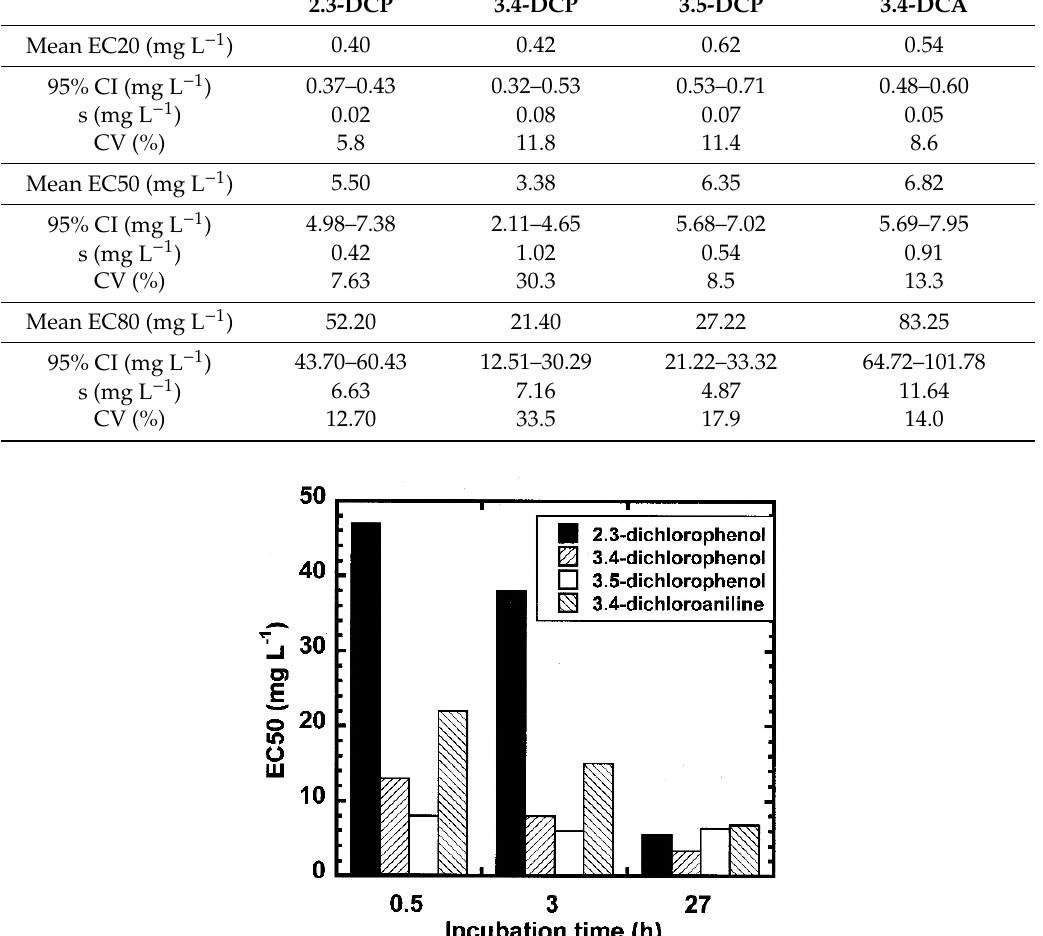
Table 5. Toxicity data for 2.3-dichlorophenol (2.3-DCP), 3.4-dichlorophenol (3.4-DCP), 3.5- dichlorophenol (3.5-DCP) and 3.4-dichloroaniline (3.4-DCA) in the long-term respiration inhibition test (27 h incubation time), according to the modified OECD 209 protocol. The number of single tests performed was 5. s = standard deviation, CI = confidence interval of the mean and CV = variation coefficient.